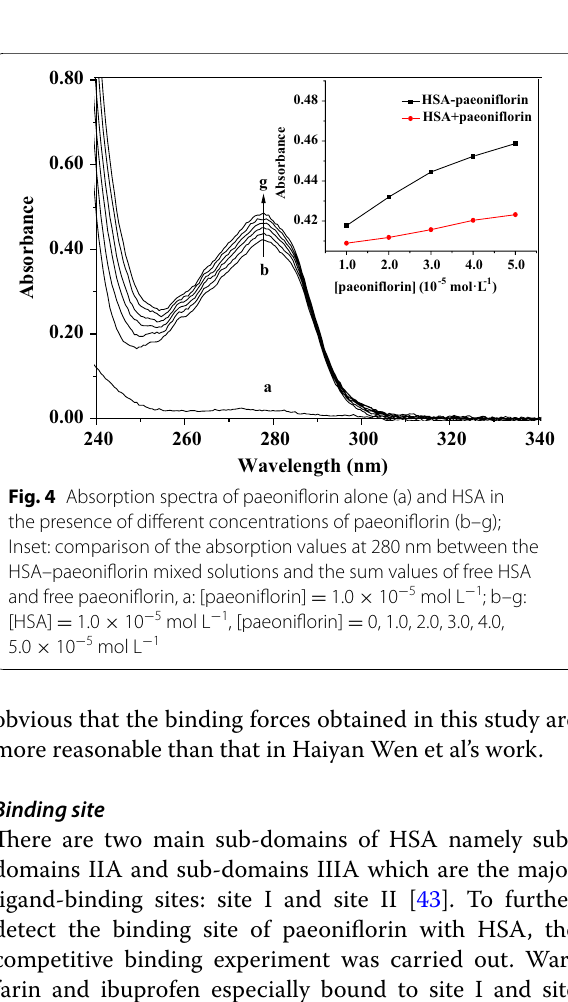
1.0 10 − 5 mol L − 1 ; b–g: = × 0, 1.0, 2.0, 3.0, 4.0, =